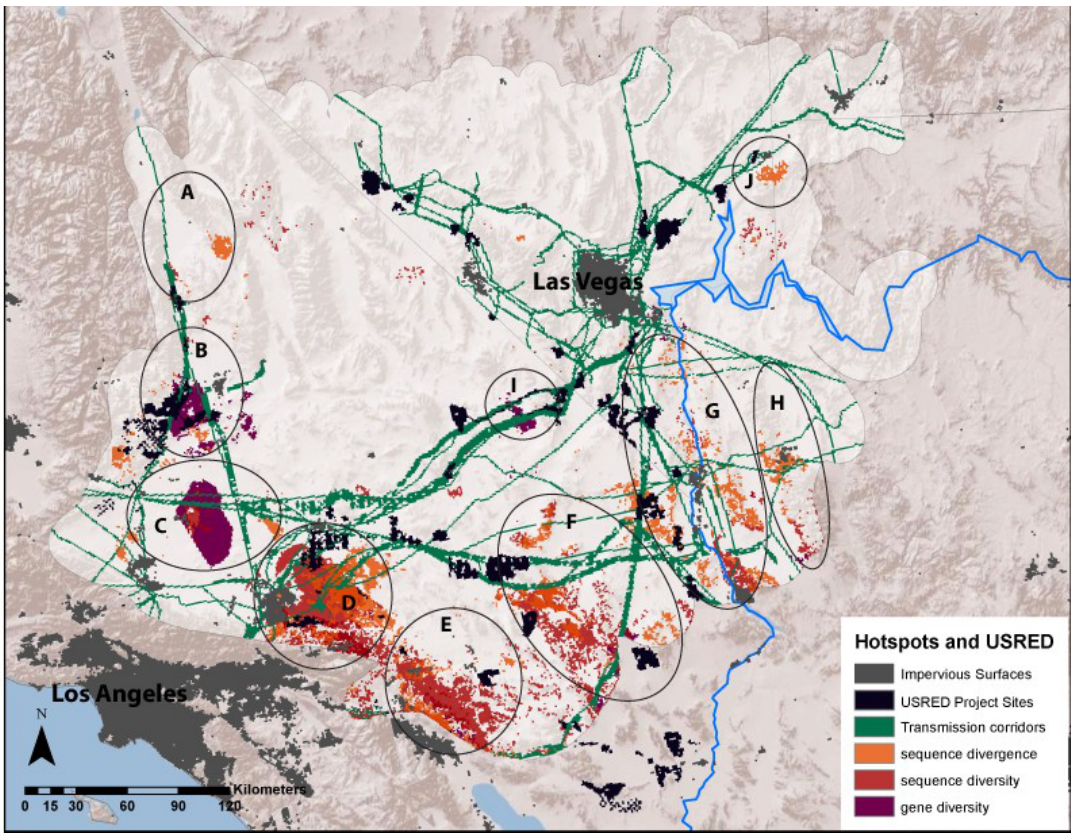
Figure 4. Ten regional hotspots of sequence divergence, sequence diversity and gene diversity overlaid with existing and pending utility scale renewable energy development (USRED) project site footprints and energy corridors. Impervious surfaces represent existing urban